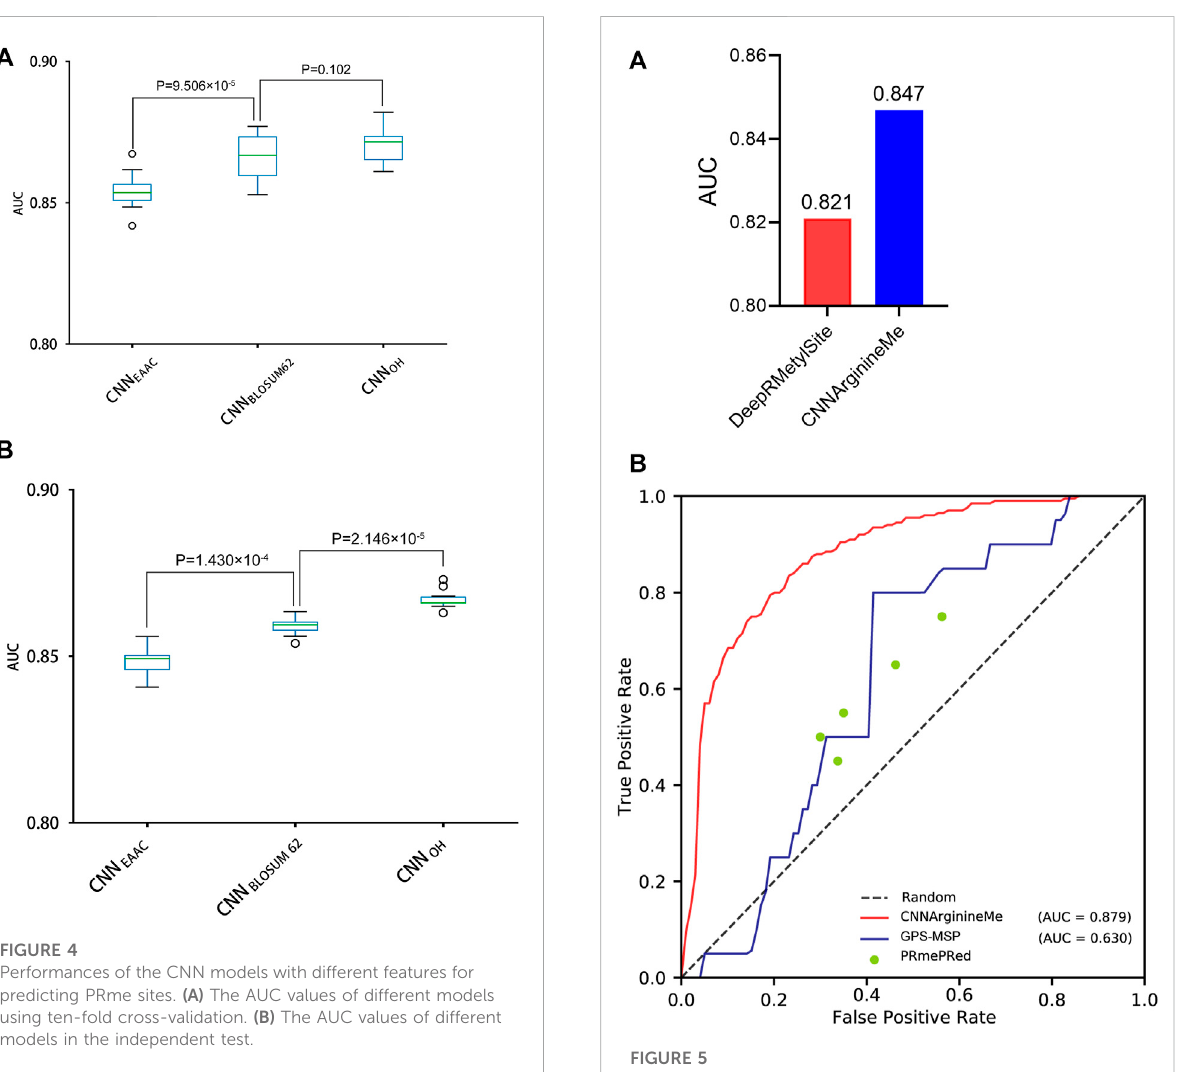
FIGURE 5 The comparison of CNNArginineMe and reported classi fi ers. (A) AUC values of reconstructed CNNArginineMe and DeepRMethylSite. (B) The comparison between CNNArginineMe and two reported online prediction models, i.e., GPS-MSP and